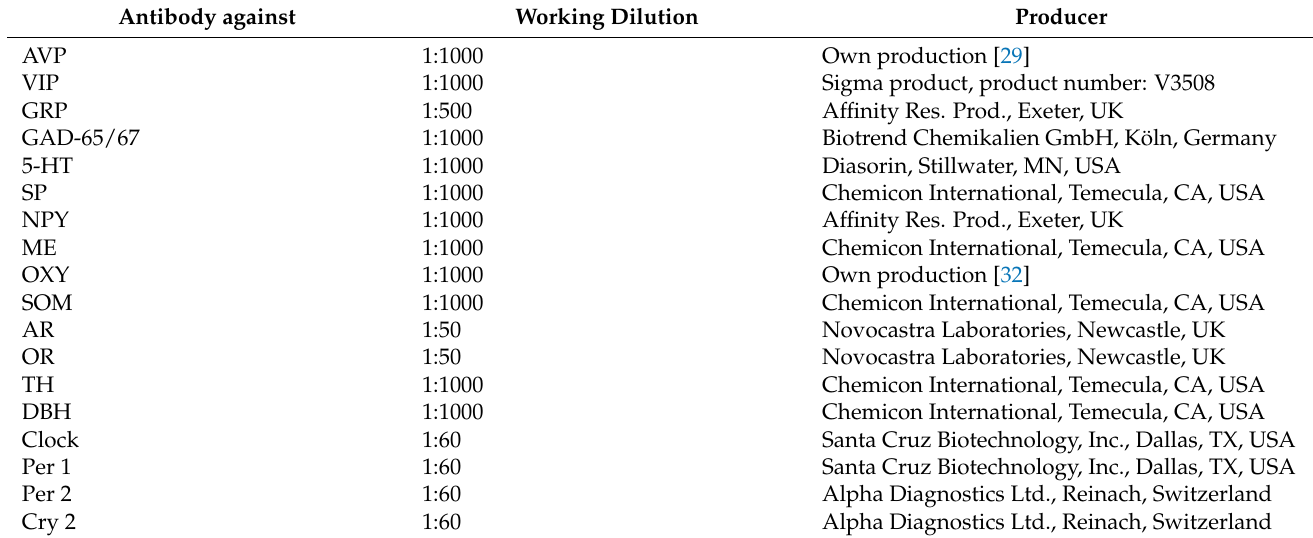
Table 1. List of antisera used for immunostaining. 5-HT = serotonin (5-hydroxy-tryptamin), AR = androgen receptor, AVP = arginine-vasopressin, Cry = cryptochrome, DBH = dopamine beta-hydroxylase (the guiding enzyme of norepinephrine synthesis), GAD-65/67 = glutamic acid decarboxylase (the guiding enzyme of GABA synthesis), GRP = gastrin-releasing peptide, ME = met-enkephalin, NPY = neuropeptide Y, OR = estrogen receptor, OXY = oxytocin, PER = Period, SOM = somatostatin, SP = substance P, TH = tyrosine hydroxylase (the guiding enzyme of dopamine synthesis), VIP = vasoactive intestinal